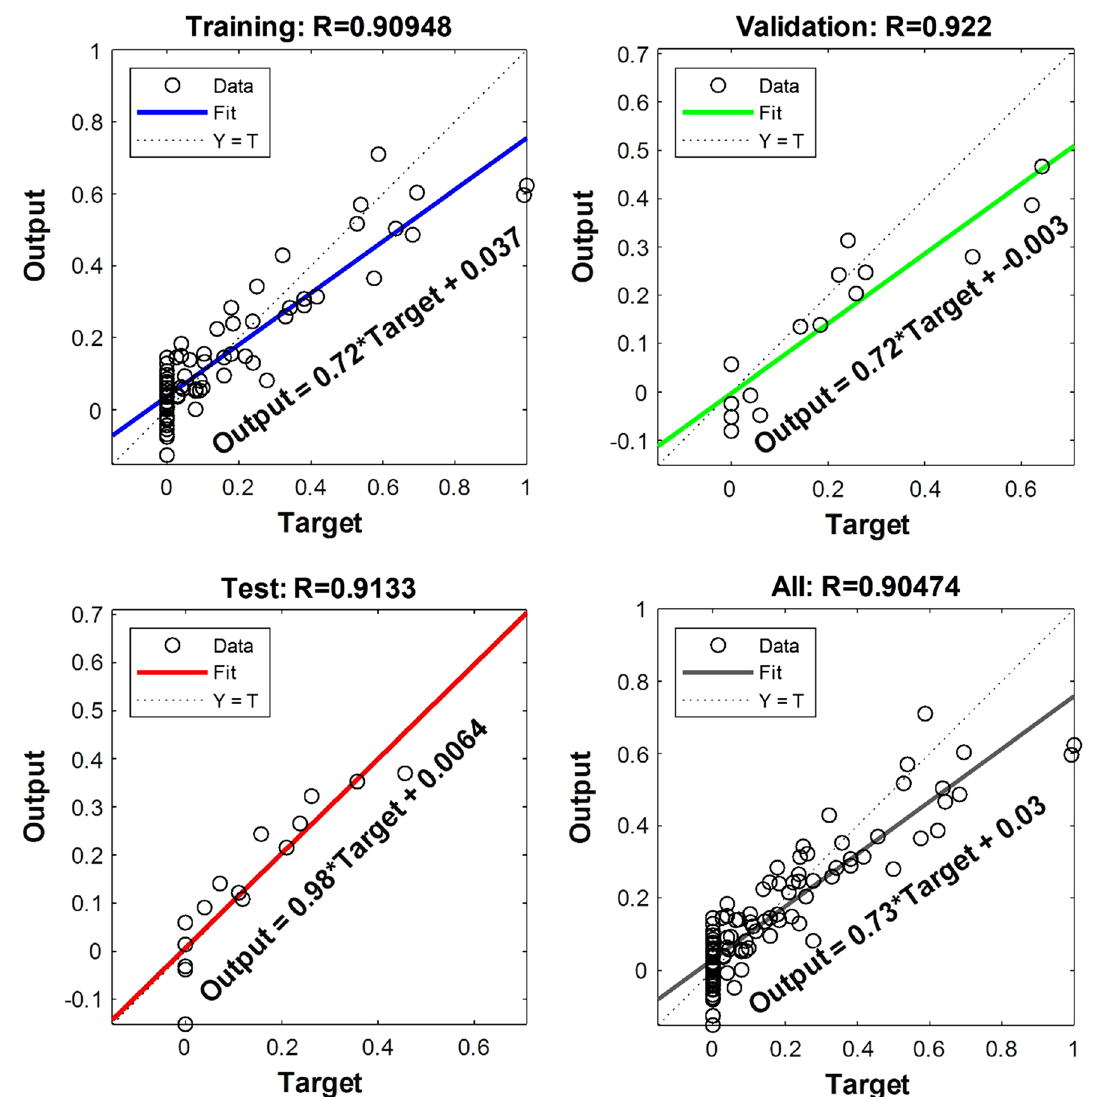
Fig. 23 The training regression of the Model No.2 (ANN 2) for liquefaction